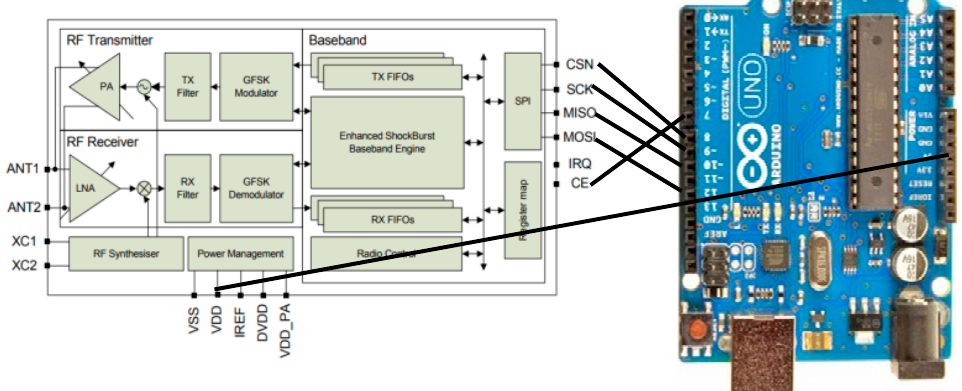
Figure 14. NRF24L01 and Aduino wiring diagram.